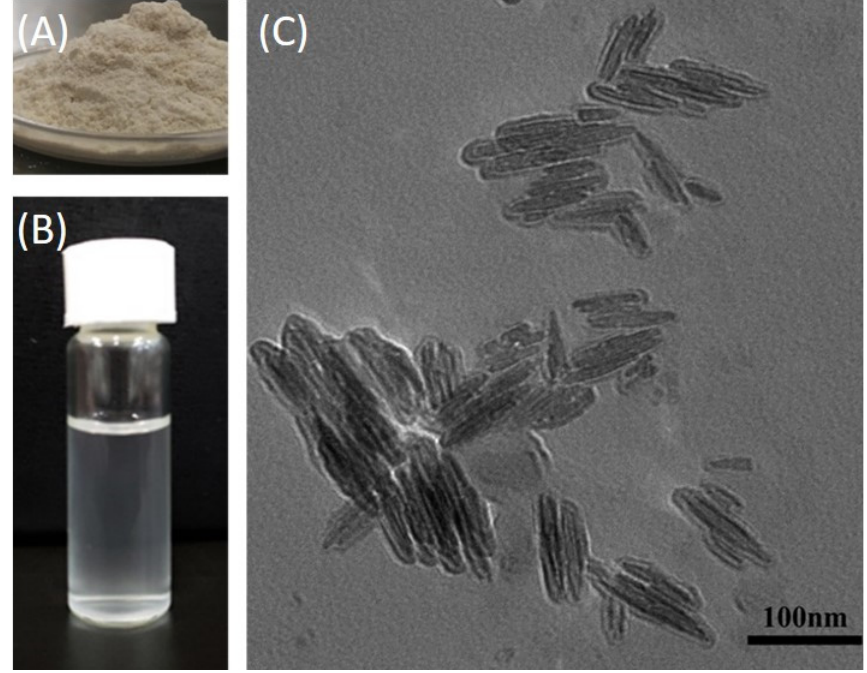
Figure 5. Photo of ( A ) CS-TA-Na powder and ( B ) its aqueous solution. ( C ) Transmission electron microscope (TEM) image of CS-TA-Na